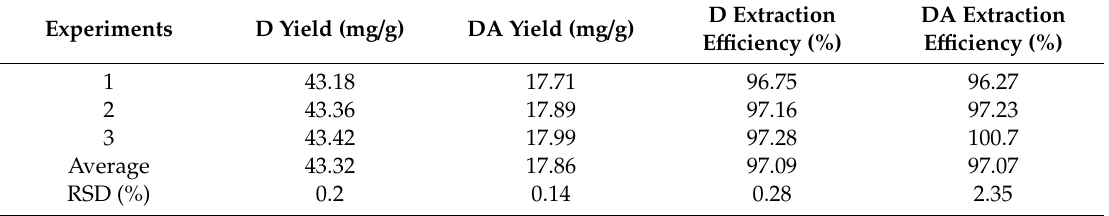
Table 3. Verification of the optimized condition: reproducibility and precision.